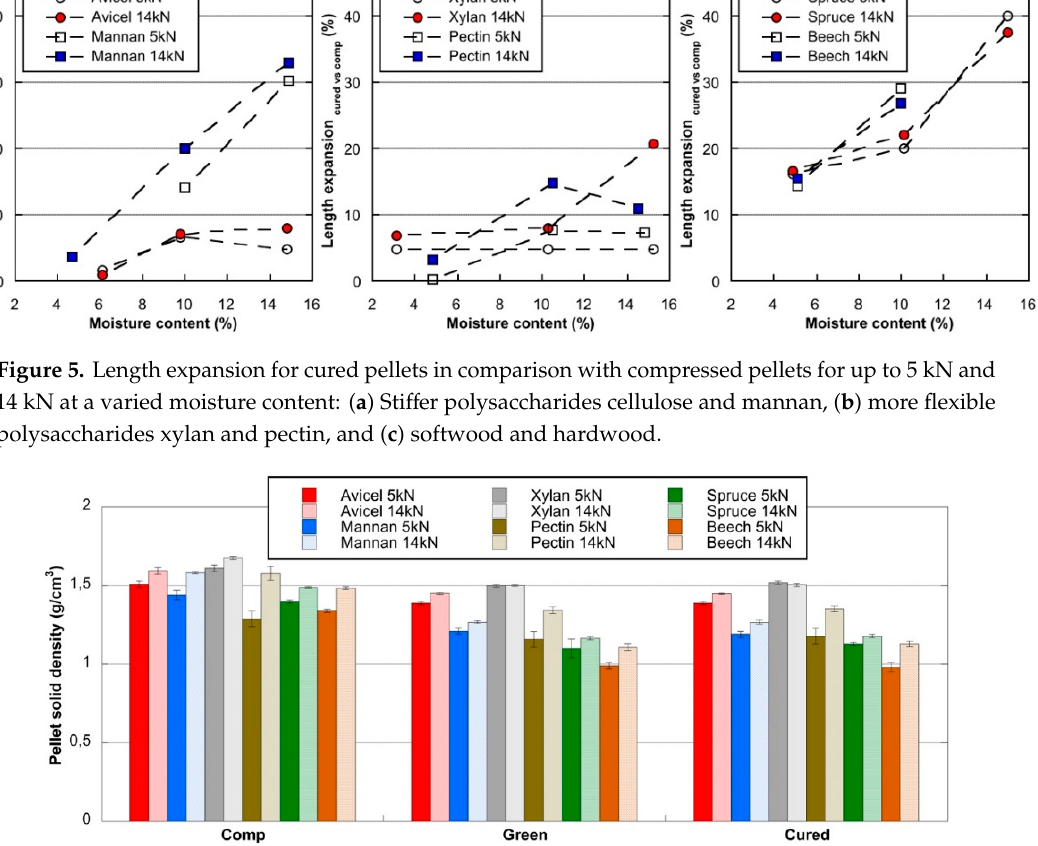
Figure 6. Pellet solid density for all of the pellets produced at a 10% moisture content at 5 kN or 14 kN.